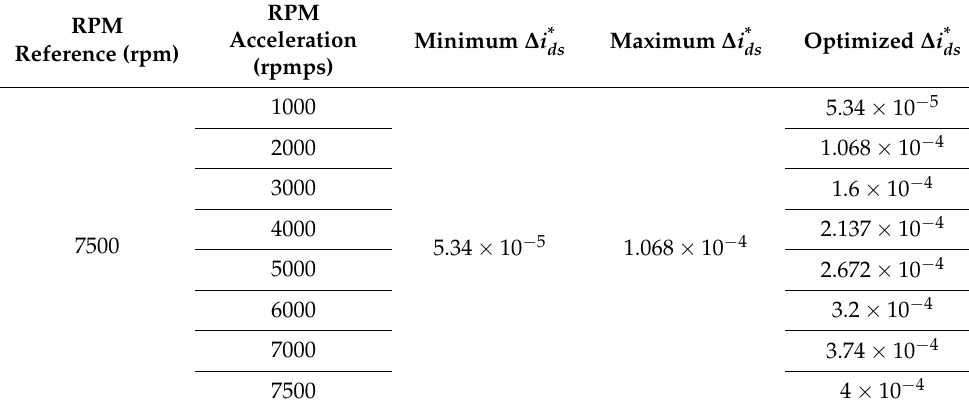
Table 2. Summary of various parameters adopted in the